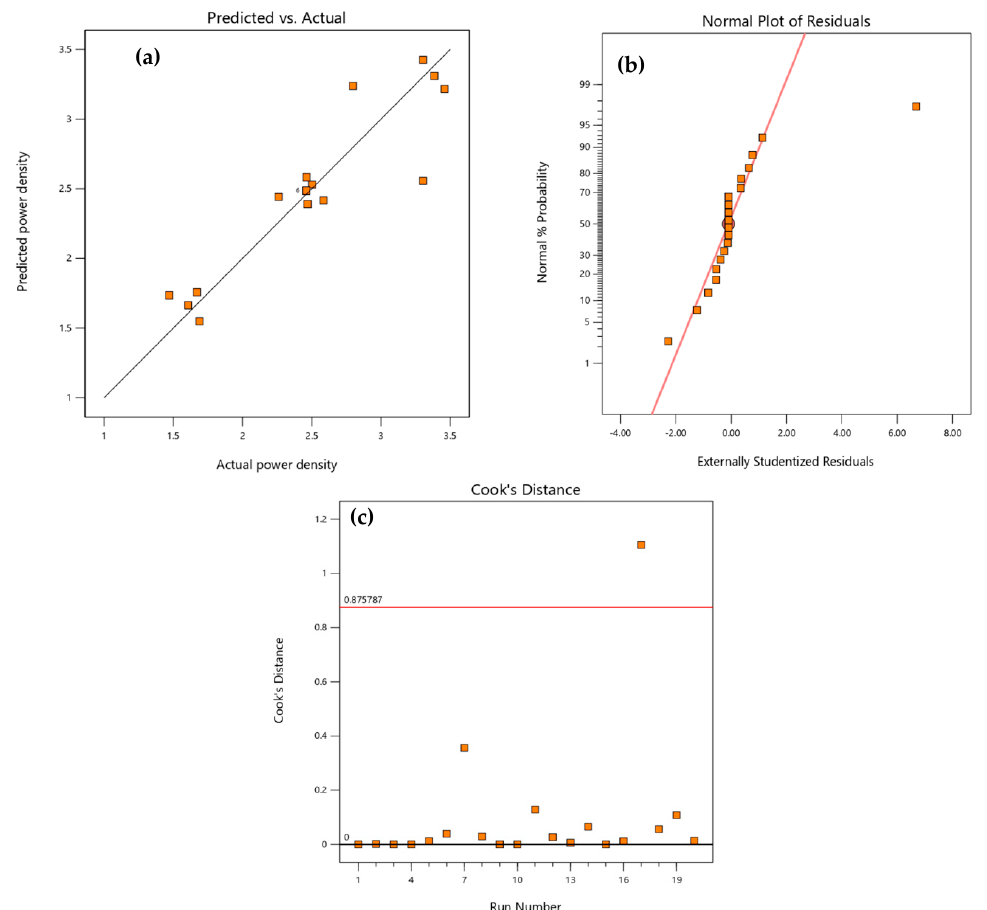
Figure 1. Analytical model validation graphs. ( a ) Predicted vs. actual. ( b ) Normal plot of residuals. ( c ) Cook’s distance.